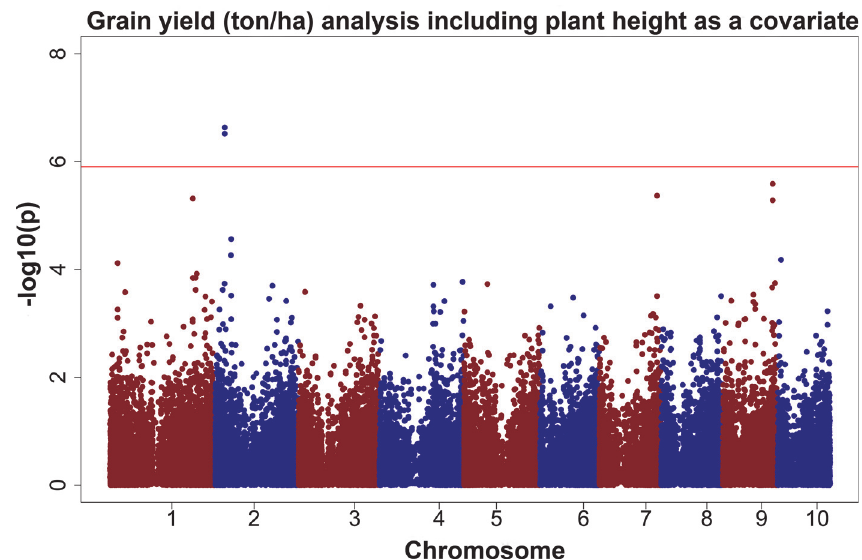
Fig 3. GWAS results for grain yield (ton/ha) using spatial adjustment and a covariate for plant height. The phenotypic observation was the BLUPs for the MET analysis, which includes AR1 x AR1 terms to adjust for column and row effects. In addition, this model includes a centered and standardized covariance for plant height. The red line represents the threshold value after correcting for multiple testing using the M eff or